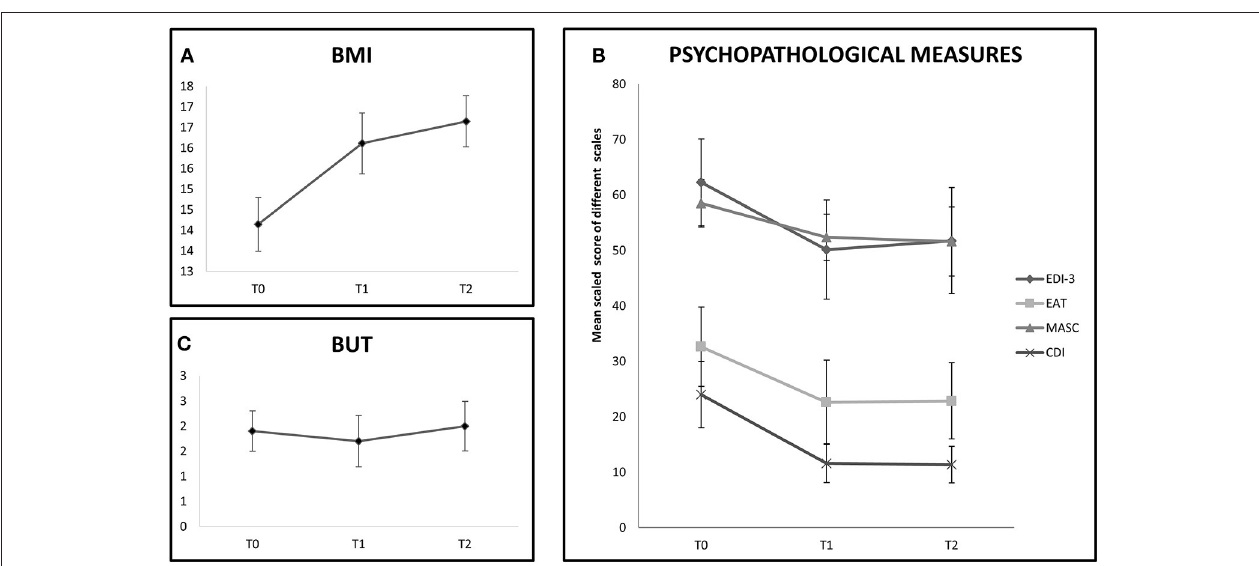
FIGURE 2 | The chart shows follow-up evalution of outcome measures in the tDCS + AU group (only 9 participants). (A) Shows BMI values expressed in mean at baseline (T0), at the end of treatment (T1) and at 1 month follow-up (T2). BMI values increased even at 1-month follow-up. (B) Shows mean scaled score of EDI-III, EAT-26, MASC, and CDI at baseline (T0), at the end of treatment (T1) and at 1 month follow-up (T2). Improvement was stable until 1-month follow-up in the EAT-26, MASC, and CDI scales, but not on EDI-III. (C) Shows mean score of BUT at baseline (T0), at the end of treatment (T1) and at 1 month follow-up (T2). No improvement was shown at any evaluation time.